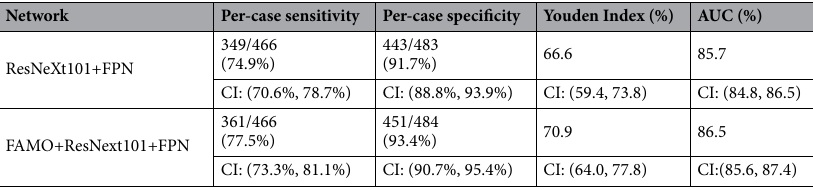
Table 2. The improvement of FAMO in per-case level. ResNeXt101, a network structure; FPN, feature pyramid network; FAMO, Feature Ambiguity Mitigate Operator (FAMO) method; AUC, area under the curve; AP, average precision; CI, confidence interval. All CIs were calculated at the two-tailed significance of 0.05.